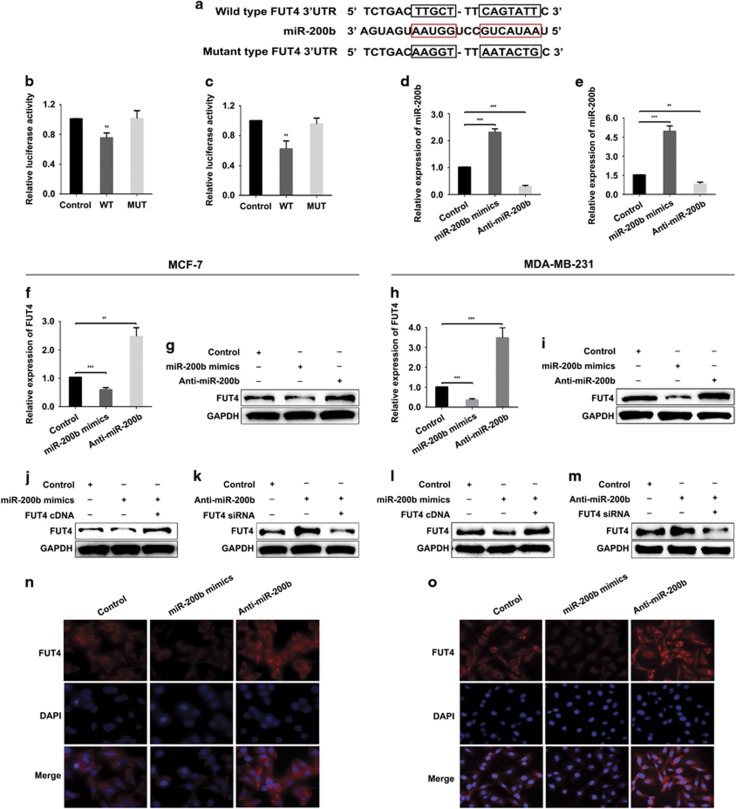
FUT4 is a novel and direct target gene for miR-200b. (a) A schematic showed reporter constructs of wild-type FUT4 3′-UTR (upper panel) and FUT4 3′-UTR with mutated miR-200b-binding sites (lower panel). (b, c) Dual luciferase gene report assay. MCF-7 and MDA-MB-231 cells were co-transfected with wild- or mutated-type reporter constructs and miR-200b mimics, respectively. Relative luciferase activity was detected by fluorescent intensity. WT: wild-type FUT4 3′-UTR transfection; MT: mutated-type FUT4 3′-UTR transfection. (d, e) Real-time PCR for the expression of miR-200b in MCF-7 and MDA-MB-231 cells after transfected with miR-200b mimics and Anti-miR-200b. (f, g) Real-time PCR and western blotting for FUT4 level in MCF-7 cells after miR-200b mimics and Anti-miR-200b transfection. (h, i) Real-time PCR and western blotting for FUT4 level in MDA-MB-231 cells after miR-200b mimics and Anti-miR-200b transfection. (j, l) Western blotting for the expression of FUT4 in MCF-7 and MDA-MB-231 cells after miR-200b mimics transfection or miR-200b mimics and FUT4 cDNA co-transfection, respectively. (k, m) Western blotting for the expression of FUT4 in MCF-7 and MDA-MB-231 cells after Anti-miR-200b transfection or Anti-miR-200b and FUT4 siRNA co-transfection, respectively. (n, o) Immunofluorescent staining of FUT4 in MCF-7 and MDA-MB-231 cells after miR-200b mimics and Anti-miR-200b transfection. Cells were immunostained with anti-FUT4 antibody (1:100) and exposed by TRITC goat anti-rabbit IgG secondary antibody (1:100). Representative images are shown by fluorescent microscope (magnification, × 400). **P<0.01, ***P<0.001.